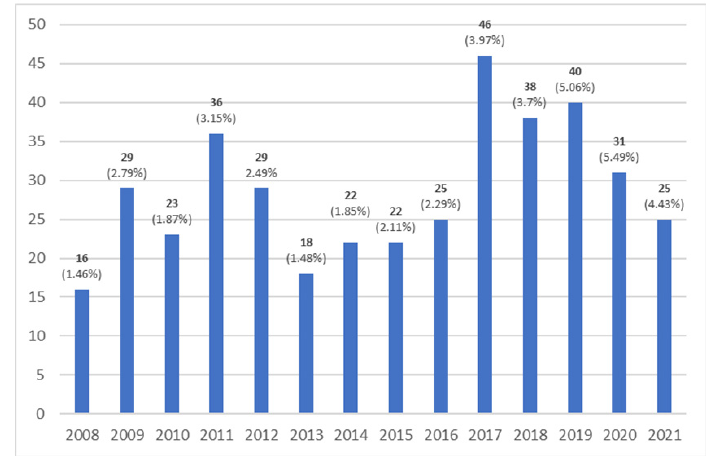
Figure 2. Annual number of dislodgements.